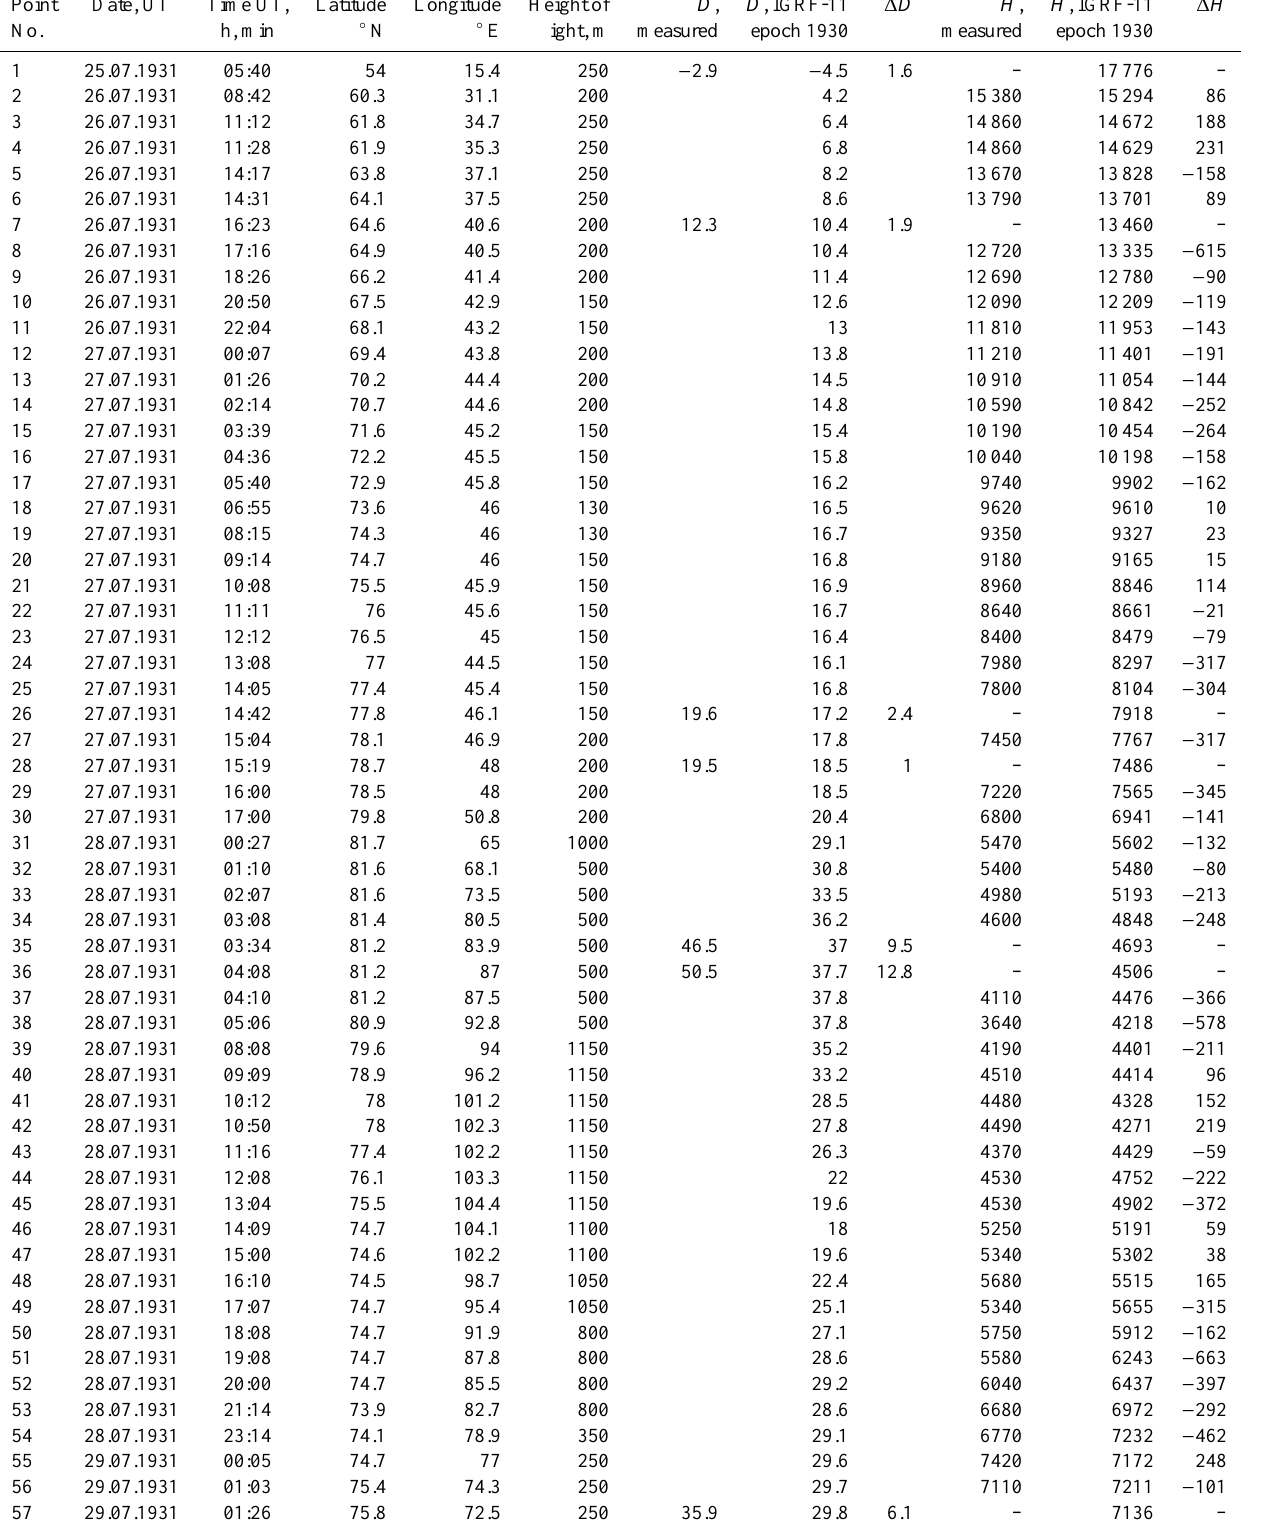
Table 1. Measurements of H and D during the airship Arctic flight and their comparison with H and D calculated from the IGRF-11 model.